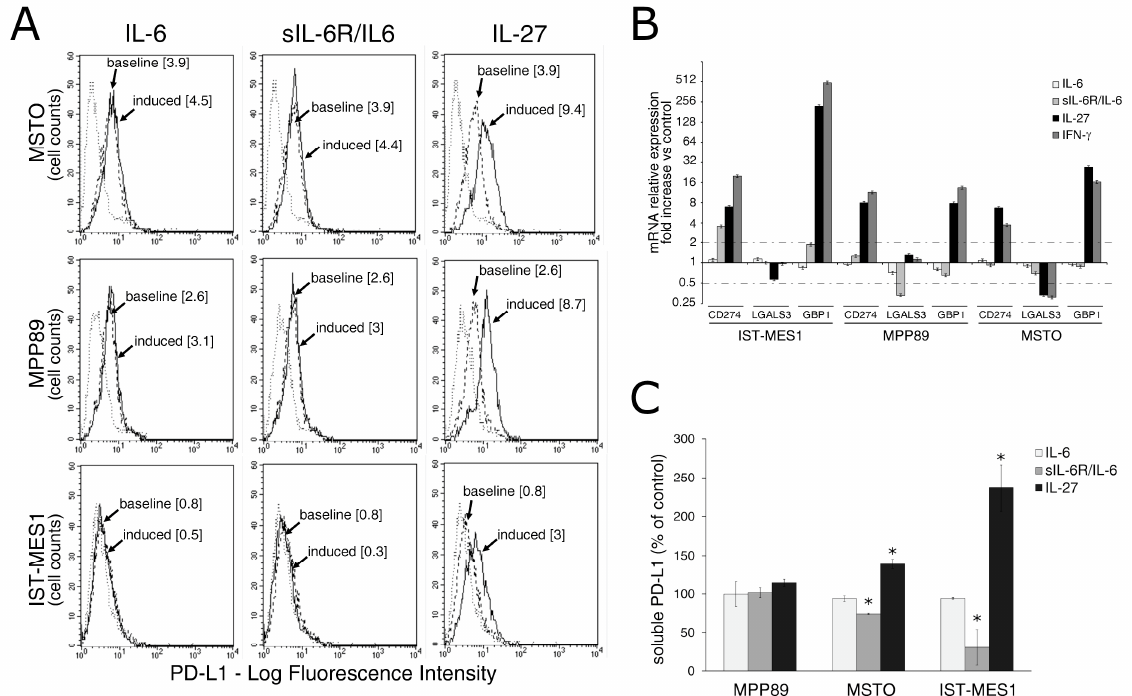
Figure 2. IL-27 upregulates PD-L1 molecule expression and release by MM cells. ( A ) Flow cytometry analysis of membrane PD-L1 expression in MSTO, MPP89, and IST-MES1 MM cell lines cultured with medium alone (baseline), IL-6, sIL-6R/IL-6 chimera, or IL-27 (induced). Dotted line shows isotype-matched Ig control. Numbers in brackets represent Median Fluorescence Intensity (MFI) values calculated as median anti-PD-L1 mAb minus median Ig control. Data are representative of two independent experiments yielding similar results. ( B ) qRT-PCR analysis of CD274 (PD-L1) mRNA expression in the same three MM cell lines stimulated with IL-6, sIL-6R/IL-6 chimera, IL-27, or IFN- γ relative to untreated cells. Data are calculated with the ΔΔ CT method and expressed as fold change versus untreated control. Error bars represent SD of triplicates. LGALS3 (Galectin 3) and GBP1 (Guanylate Binding Protein 1) mRNA levels are shown, respectively, as negative and positive controls of IL-27 activity. ( C ) Evaluation by ELISA of soluble (s)PD-L1 release in the conditioned media of the indicated MM cells treated with IL-6, sIL-6R/IL-6 chimera, or IL-27. Data are expressed as a percent of untreated control and are the mean of two independent experiments, run in duplicates. Error bars represent the minimum and maximum values (* p < 0.001, Student’s t-test versus untreated control).